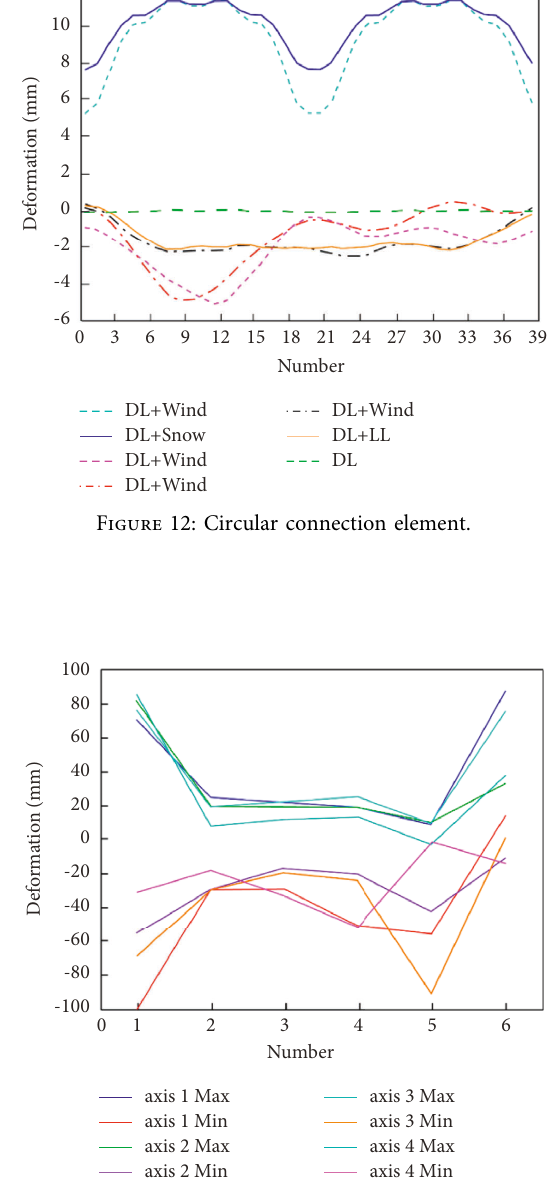
Figure 13: Radial connection element.